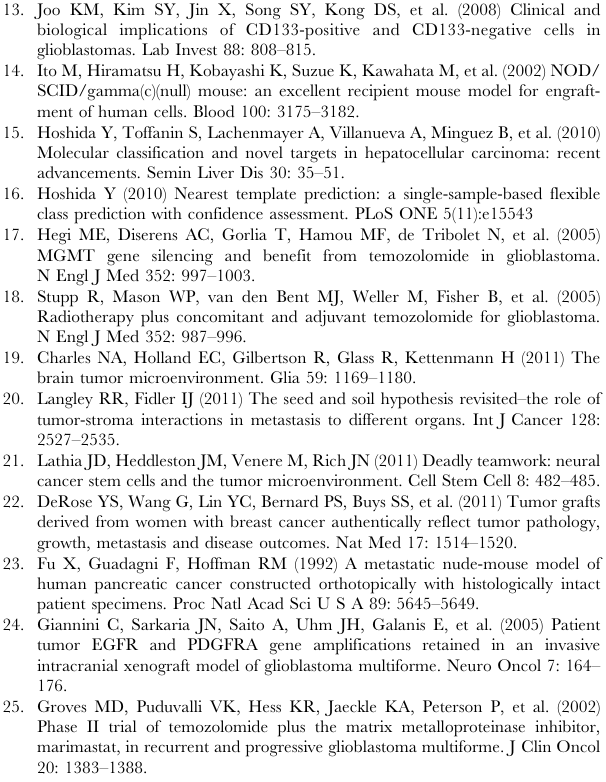
Figure S1 The inhibition effect of molecular subtype- specific drugs on patient-derived GBM cells. The inhibition effect of molecular subtype-specific drugs on the in vitro clonogenicity of matched-subtype patient-derived GBM cells was determined by limiting dilution assay in 13 patient-derived GBM cells. When the ratio of GBM cells with in vitro sphere- forming capacity was significantly reduced in in vitro limiting dilution test (Chi-Square test) compared with control group (DMSO only), the treatment results were represented by graphs. (TIF) Figure S2 The tumor status which is derived from xenograft model in each 4 subtype. By NTP method, 25 patient-derived xenograft tumor samples were determined each TCGA subtype. Based on the results of this, representative images of H&E (Hematoxylin&Eosin) staining were selected in each subtype-specific. The scale bar (white bar) represents 100 m M.